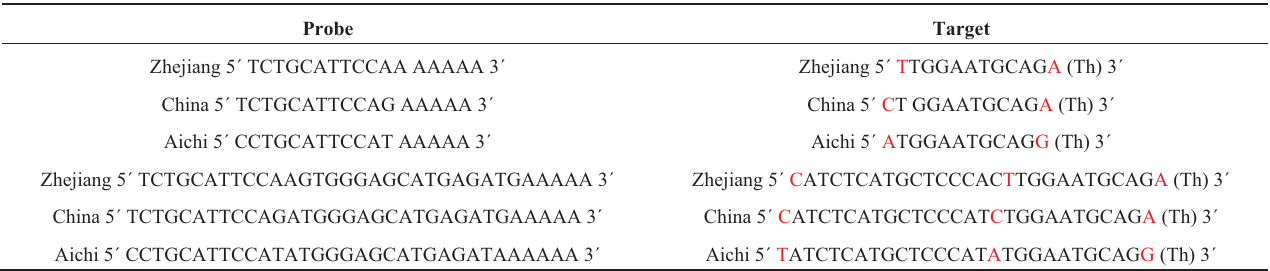
Table 1. Probes and target DNA oligonucleotides derived from influenza gene for neuraminidase.